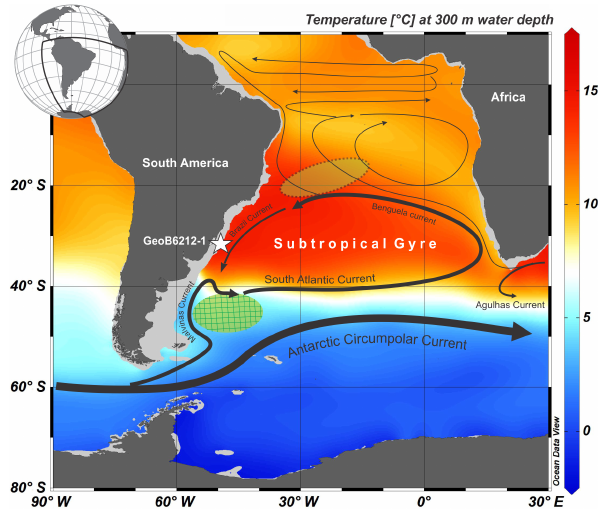
Figure 1. Schematic representation of the large-scale circulation of South Atlantic Central Water (SACW) (Stramma and England, 1999). The main SACW source region is depicted by the gridded green ellipse, and the main source region of Tropical Surface Water (TW) is indicated by the dotted yellow ellipse. Mean annual tem- perature at 300m water depth is shown by the colour shading (Lo- carnini et al., 2013)